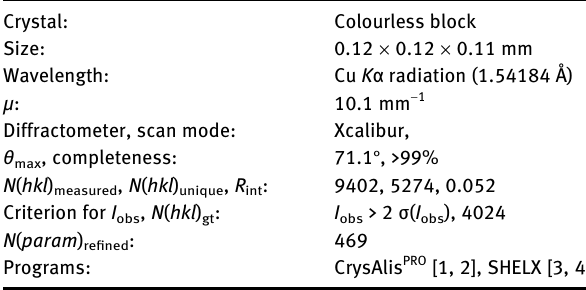
Table 1 contains crystallographic data and Table 2 contains the list of the atoms including atomic coordinates and displacement parameters.